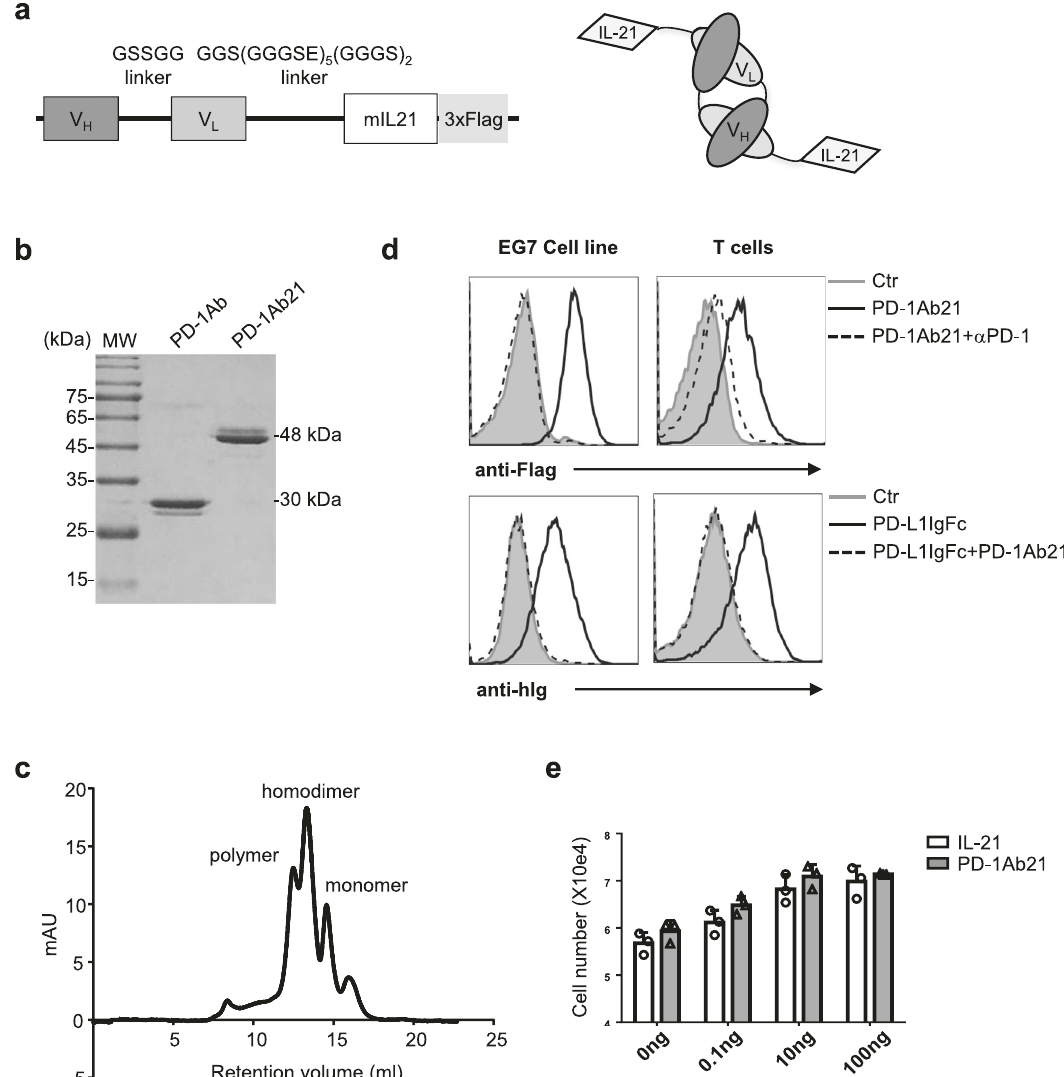
Fig. 1 Cloning, expression, and characterization of PD-1Ab and PD-1Ab21. a Schematic of the cloning strategy (left) and domain assembly (right) of PD-1Ab21. b SDS-PAGE analysis of the puri fi ed proteins PD-1Ab (30 kDa) and PD-1Ab21 (48 kDa). MW, molecular weight. c Analytical size-exclusion chromatography of PD-1Ab21. Expected elution volumes were as follows: monomer, 15 ml; dimer, 13 ml; polymer, 12 ml. Protein elution was monitored by measuring absorbance at 280 nm. d Binding of PD-1Ab21 to PD-1 + cells. EG7 (left) or activated OT-1 cells (right) were stained without (as control, fi lled grey histogram) or with PD-1Ab21 in the presence (dashed line histogram) or absence (black line histogram) of anti-PD-1 antibody, and then followed by staining with anti- fl ag antibody (top). Or the cells were stained without (as control, fi lled grey histogram) or with PD-L1IgFc in the presence (dashed line histogram) or absence (black line histogram) of PD-1Ab21, and then followed by staining with anti-hIg antibody (bottom). e Detection of IL-21 bioactivities. Baf3 cells were cultured with medium only (as control), IL-21 or PD-1Ab21 for 3 d and counted using a cell counter ( n = 3 replicates /group). Results are presented as mean ± SEM and are representative of more than three independent